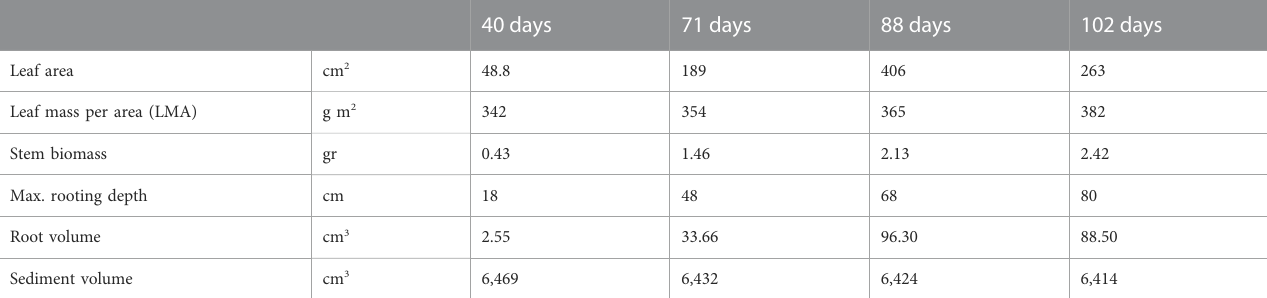
TABLE 3 Plant characteristics at 40, 71, 88, and 102 days, as measured from harvested